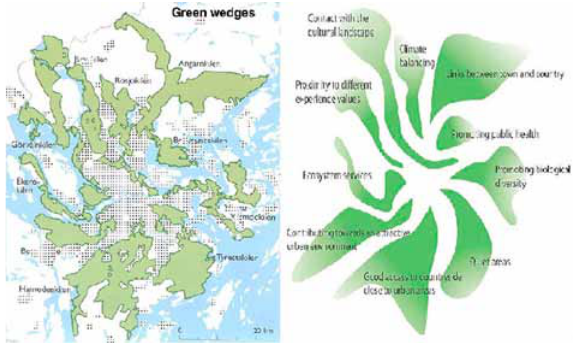
fig. 3. Map of Stockholm’s Green Wedges, comprising 10 wedges with a number of benefits (lahti et al. 2007 (left- hand part)) and ruSf Stockholm County Council, Growth and regional Planning management, 2010 (right-hand part))